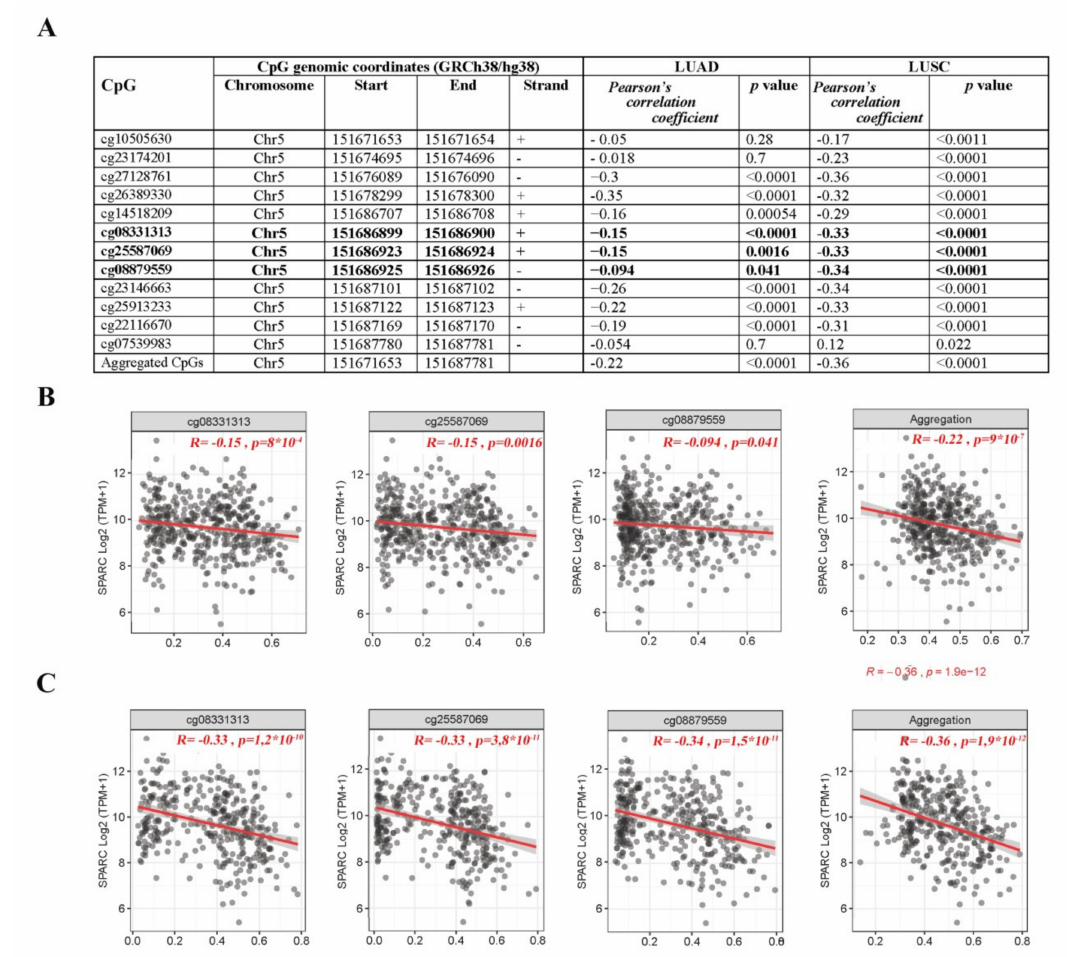
Figure 7. Correlation analysis between SPARC methylation (450 K BeadChip array, Beta-values) and expression (RNA-Seq, Transcripts per million, TPM-normalized read counts) values from TCGA-LUAD and TCGA-LUSC datasets. ( A ) Probes ID, chromosomal location, Pearson’s correlation coe ffi cient and significance level. Bold lines refer to the three CpGs located in the SPARC island included in the QMSP assay. Scatter plots between β -values (x-axis) and expression values of SPARC in ( B ) LUAD and ( C ) LUSC TCGA datasets and concerning the CpGs located in the promoter region subjected to QMSP analysis in our study